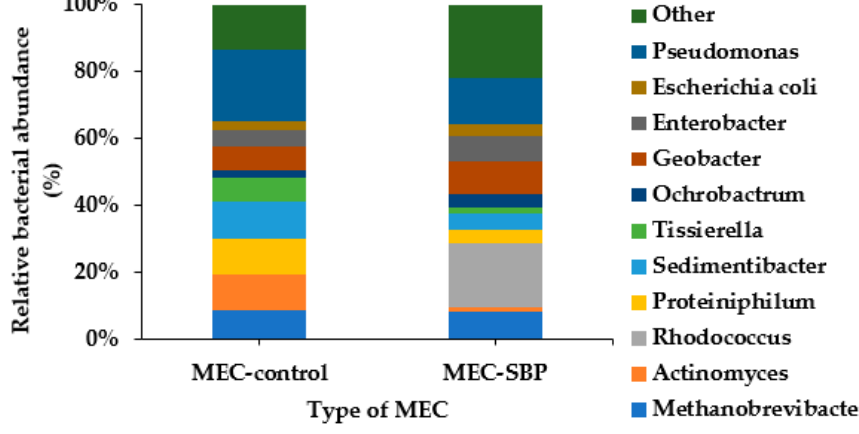
Figure 8. Relative bacterial abundance with respect to the genus level on biofilm anodes of the MEC control and MEC-SBP.